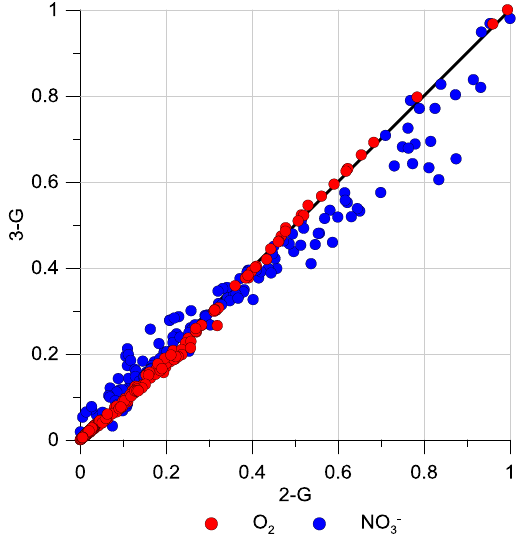
Figure 5. Normalized benthic O 2 and NO − sus 2-G models. The solid line indicates the 1 : 1